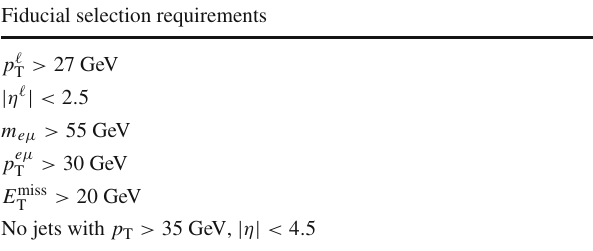
Table 3 Definition of the WW → e μ fiducial phase space Fiducial selection